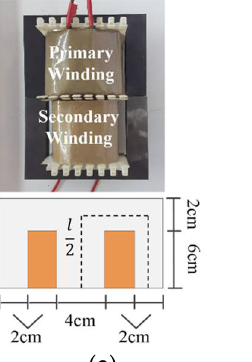
Figure 2. B-H curve of lamination materials: FeSi, VaCoFe obtained experimentally and from man- ufacturer’s datasheet.